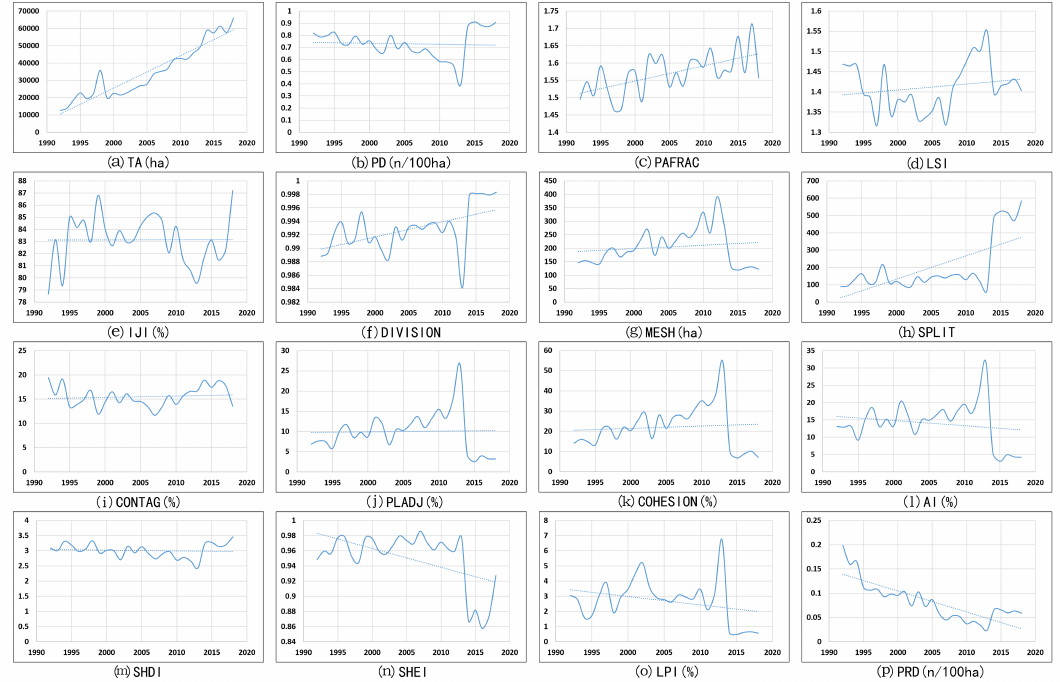
Figure 14. Analysis chart of 16 kinds of landscape index